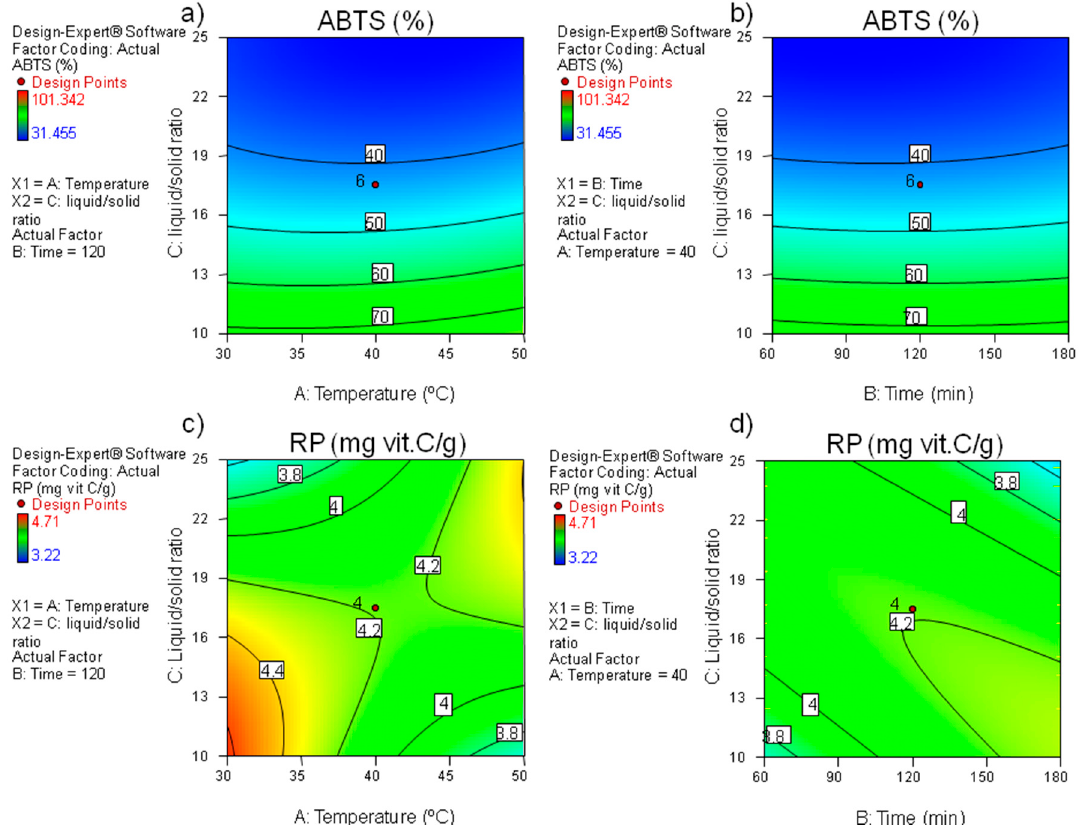
Figure 2. Contour plots for the effect of extraction variables on ( a , b ) ABTS values (% inhibition) and ( c , d ), RP values (mg ascorbic acid/g BSG). Table 3. Pearson’s correlation coefficient calculated for the response variables.